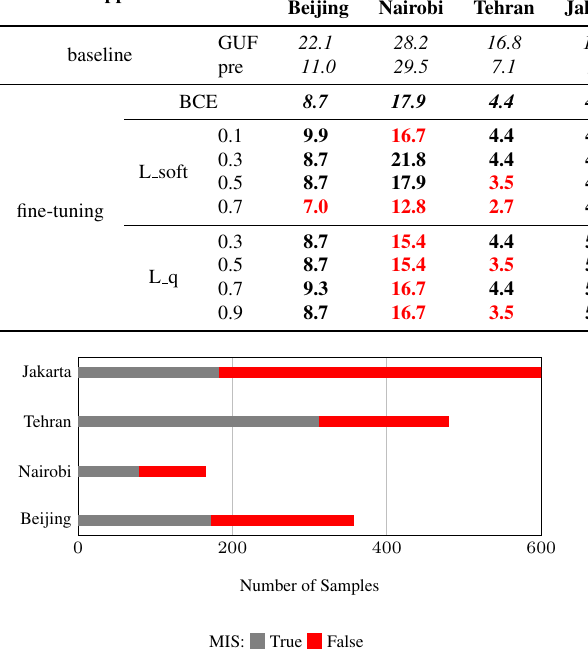
Figure 3. Number of MLGCPs for MIS mapping